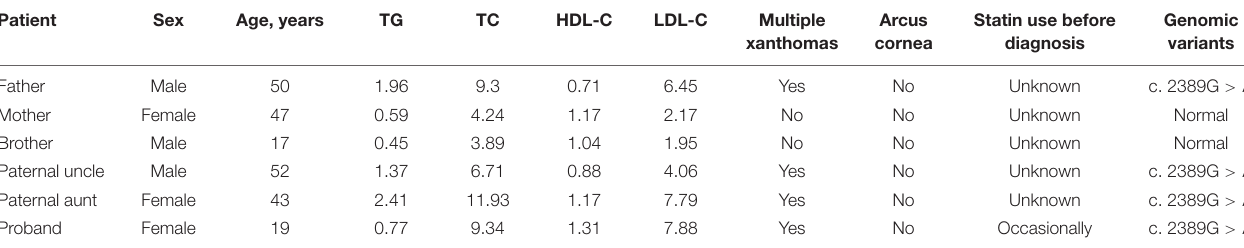
TABLE 1 | Results of lipids analyses at admission for the proband and her relatives.